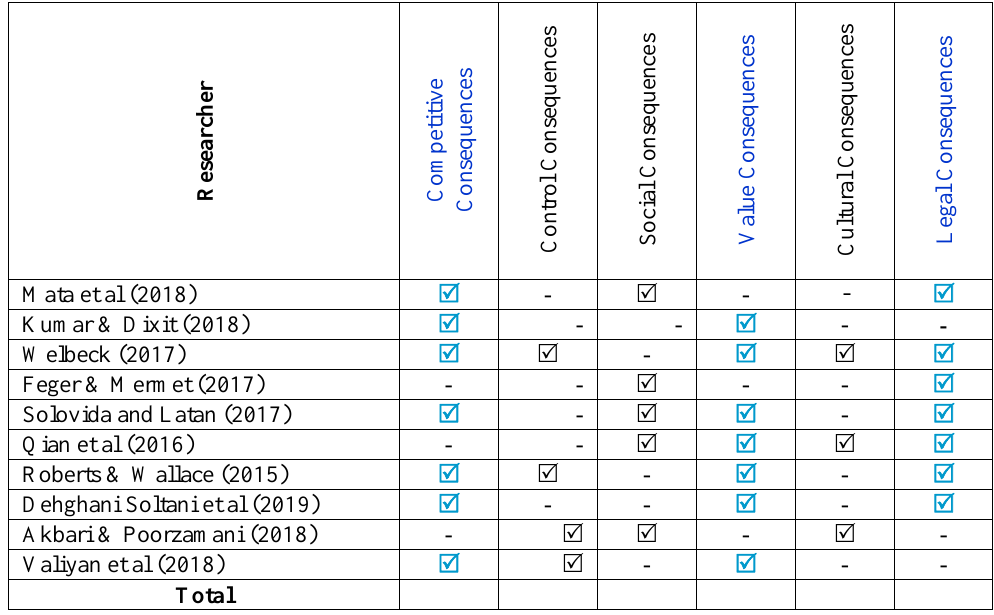
Table 5. Analysis of the main components of the strategic Consequences of green accounting across the capital